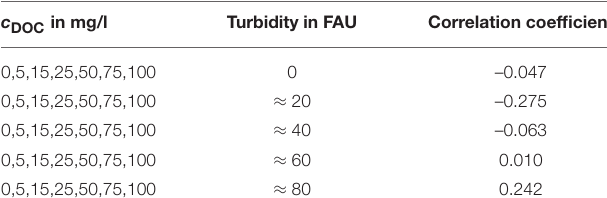
TABLE 3 | Correlation coefficients between the UV sensor signals and the different DOC concentrations and the corresponding turbidity values.